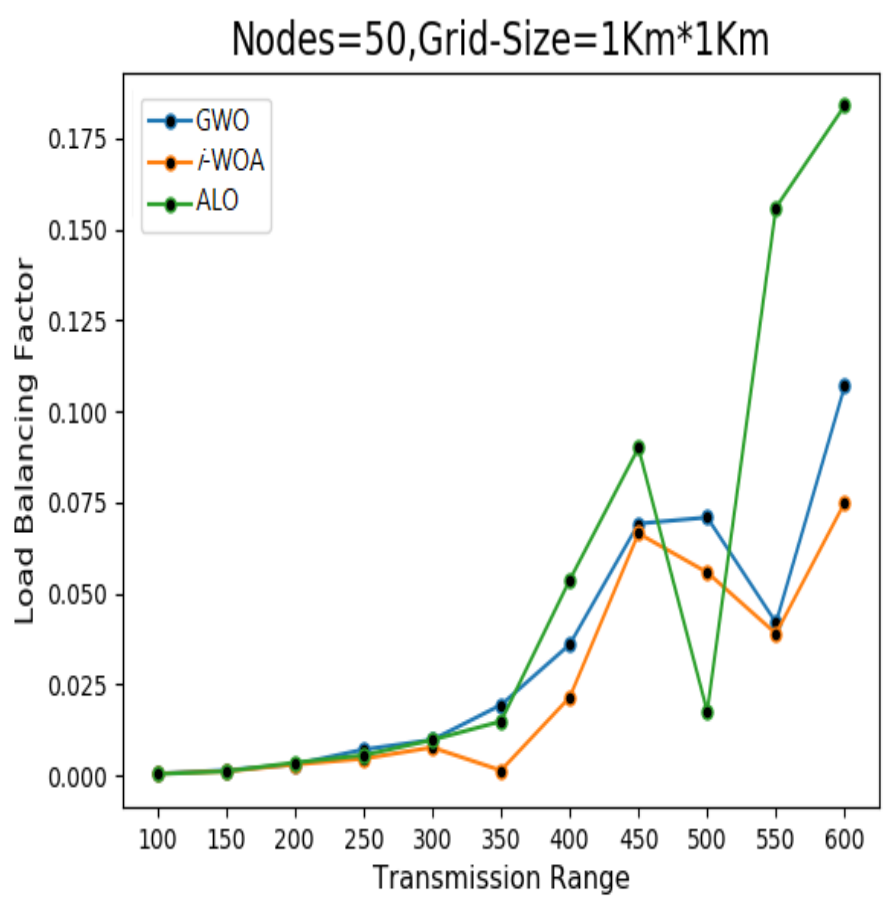
Figure 11. Load balance factor for 50 Nodes at the Grid size of 1 Km × 1 Km .